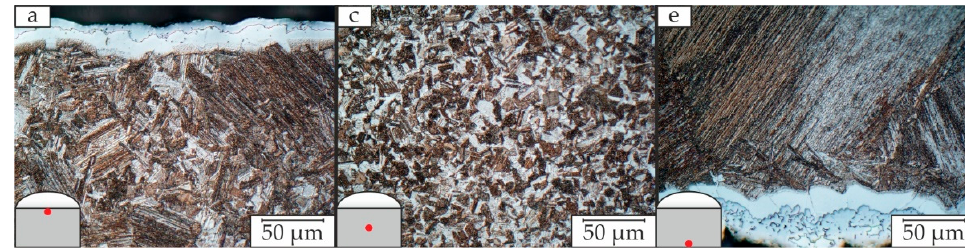
Figure 9. Microstructure in defined positions a, c and e according to Figure 1 (right) of a GE48 sample sintered at 1250 °C, with 10 min dwell time and 65 MPa pressure.